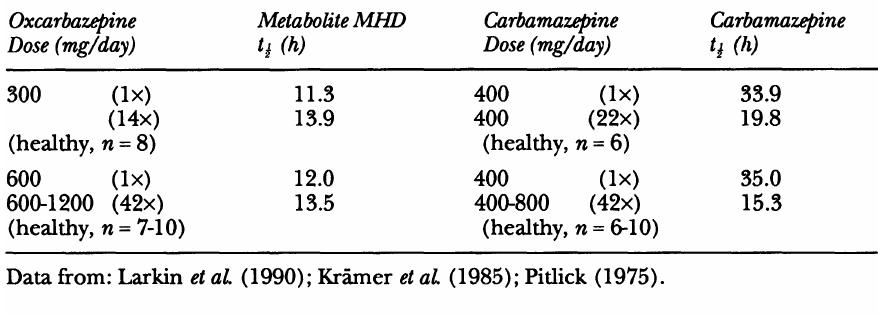
TABLE 2. Half-lives of antipyrine in man after exposure to oxcarlJazepine and carlJamazepine OxcarlJazepine